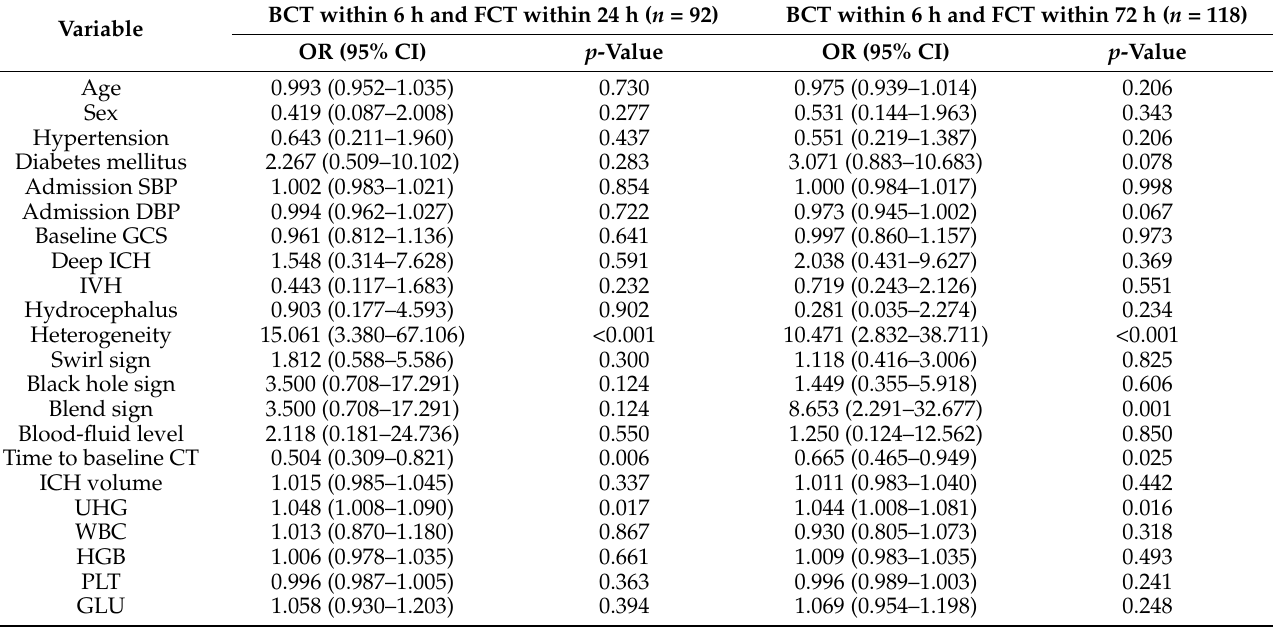
Table 3. Univariate analysis of the predictors of hematoma expansion for the time to baseline CT within 6